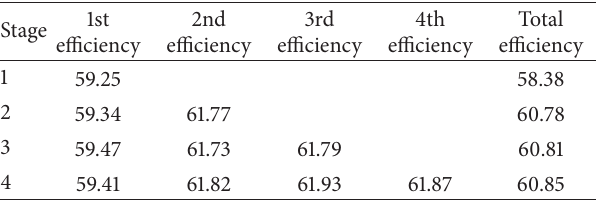
Figure 2: Schematic of the computational domain.